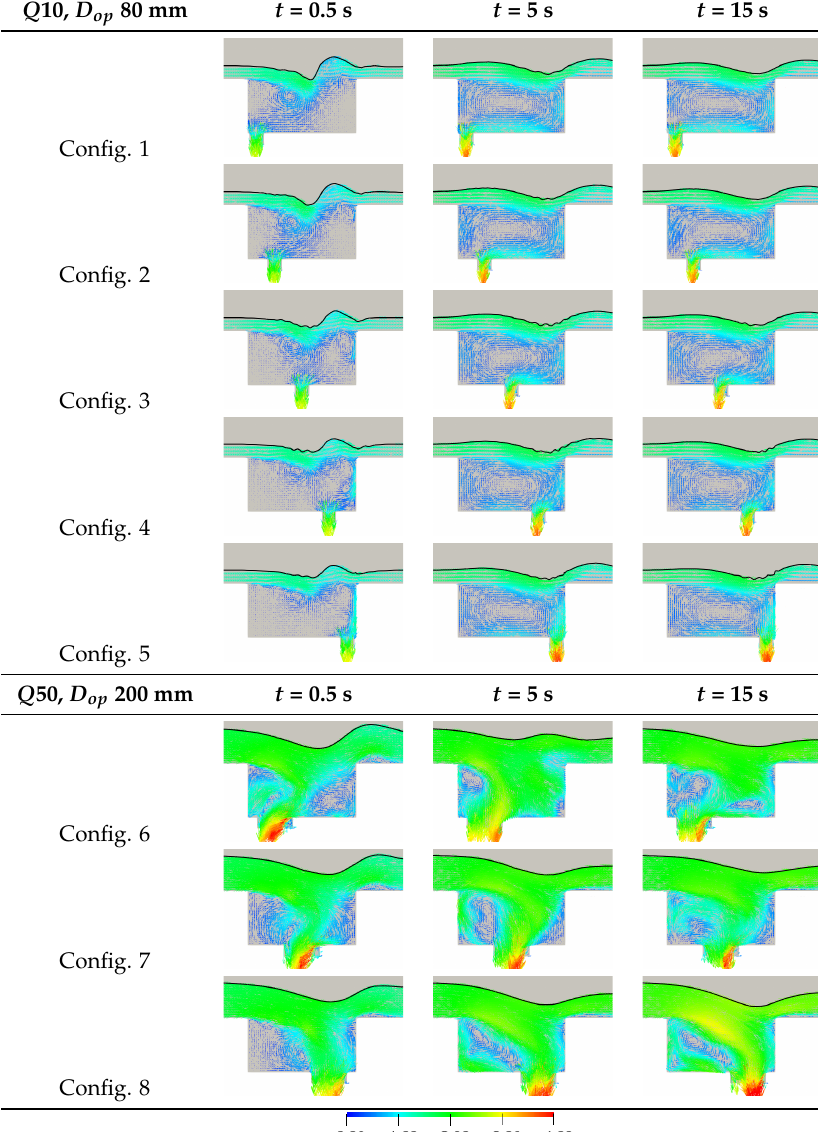
Table 5. Flow through the gully in its central plane—Config. 1 to 5, D = 80 mm for Q50 and Configurations 6 to 8, D = 200 mm